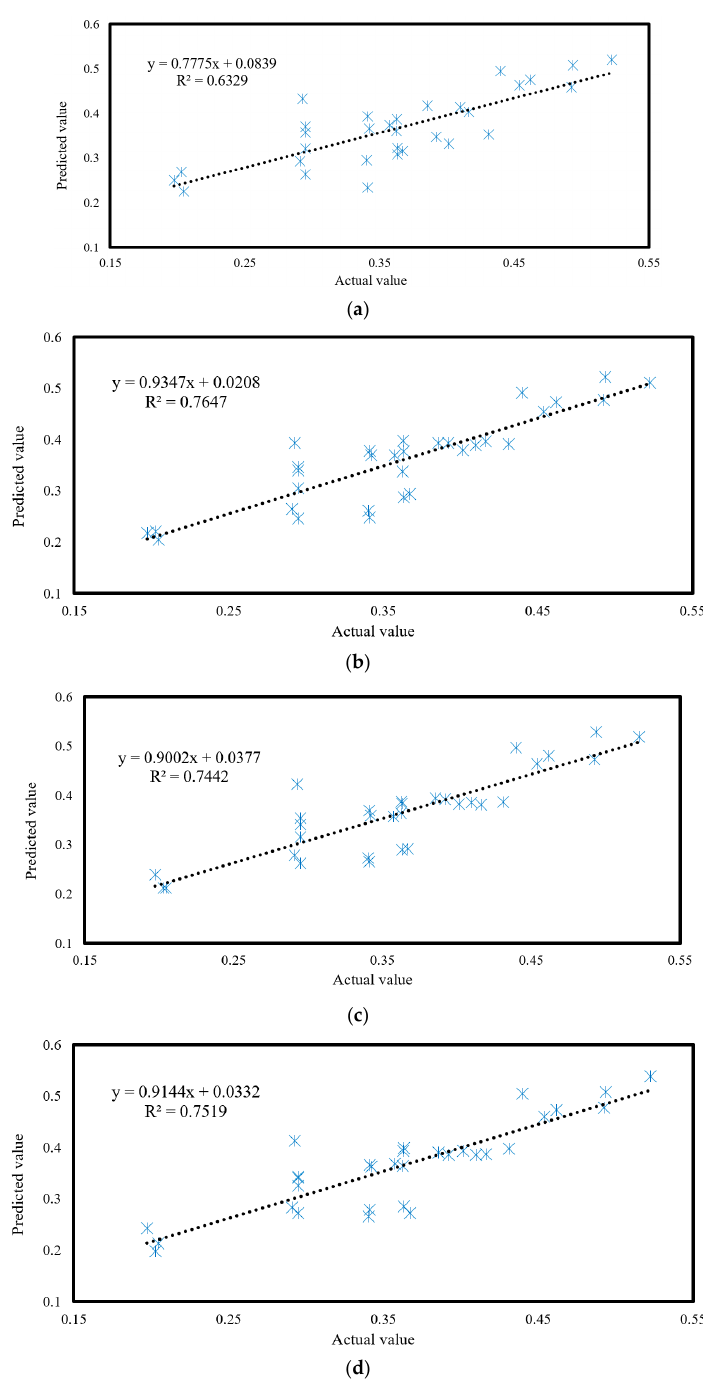
Figure 10. The testing results obtained for ( a ) ANN, ( b ) DA-ANN, ( c ) WOA-ANN, and ( d ) IWO-ANN.